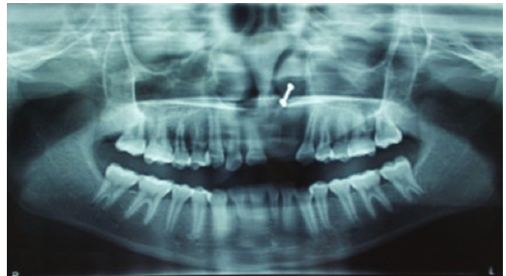
Figure 2: Orthopantomograph showing missing tooth number 21 and tooth number 22.